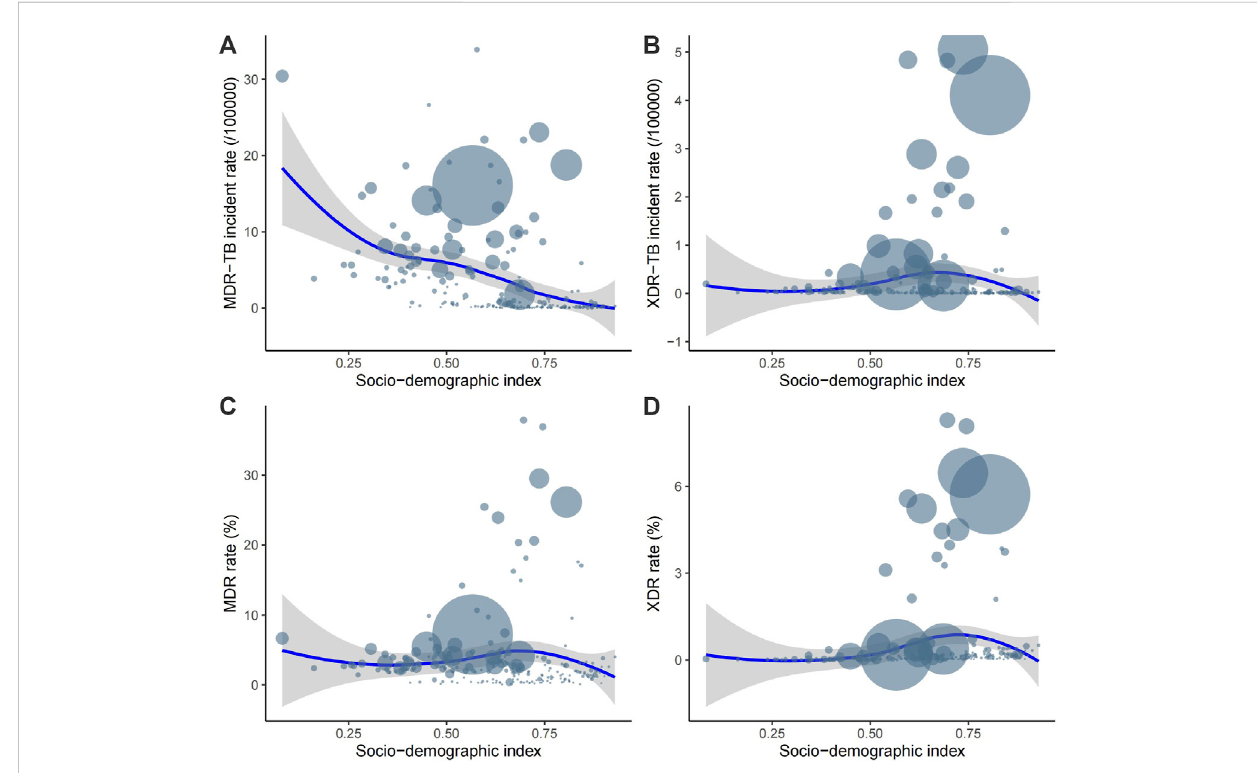
ThecorrelationbetweenASRofMDR-TB (A) ,ASRofXDR-TB (B) ,MDRrate (C) ,andXDRrate (D) andSDI.Eachcirclerepresentsacountryorterritory. The size of the circle represents the number of cases. Abbreviations: ASR, age-standardized rate; MDR, multidrug-resistant; TB, tuberculosis; XDR, extensively drug-resistant; SDI, socio-demographic